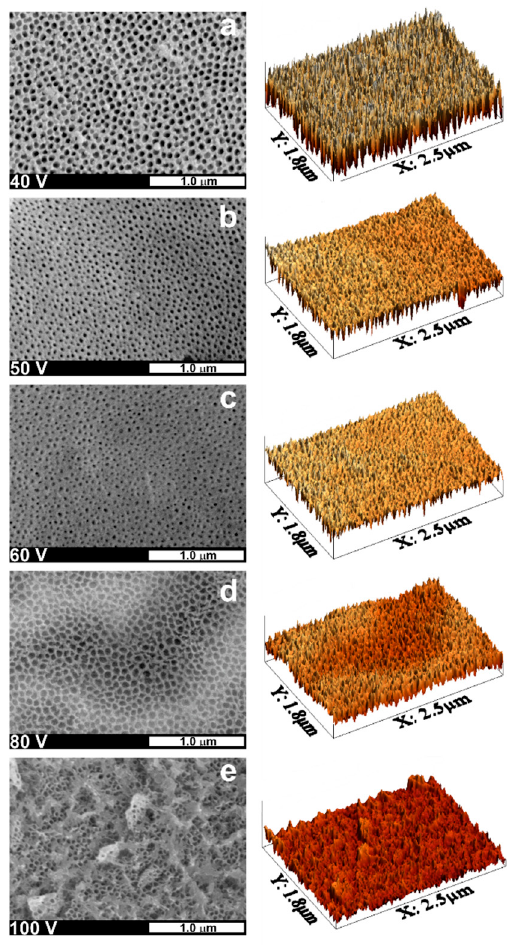
Figure 4. FE-SEM microphotographs of the surface of Ti15Mo alloy samples anodized in the ethylene glycol-based solution for 15 min at different applied potentials (i.e., ( a )—40 V, ( b )—50 V, ( c )—60 V, ( d )—80 V, and ( e )—100 V), together with 3D representatives of the respective FE-SEM images. The magnification of the SEM images was 50.0 k.